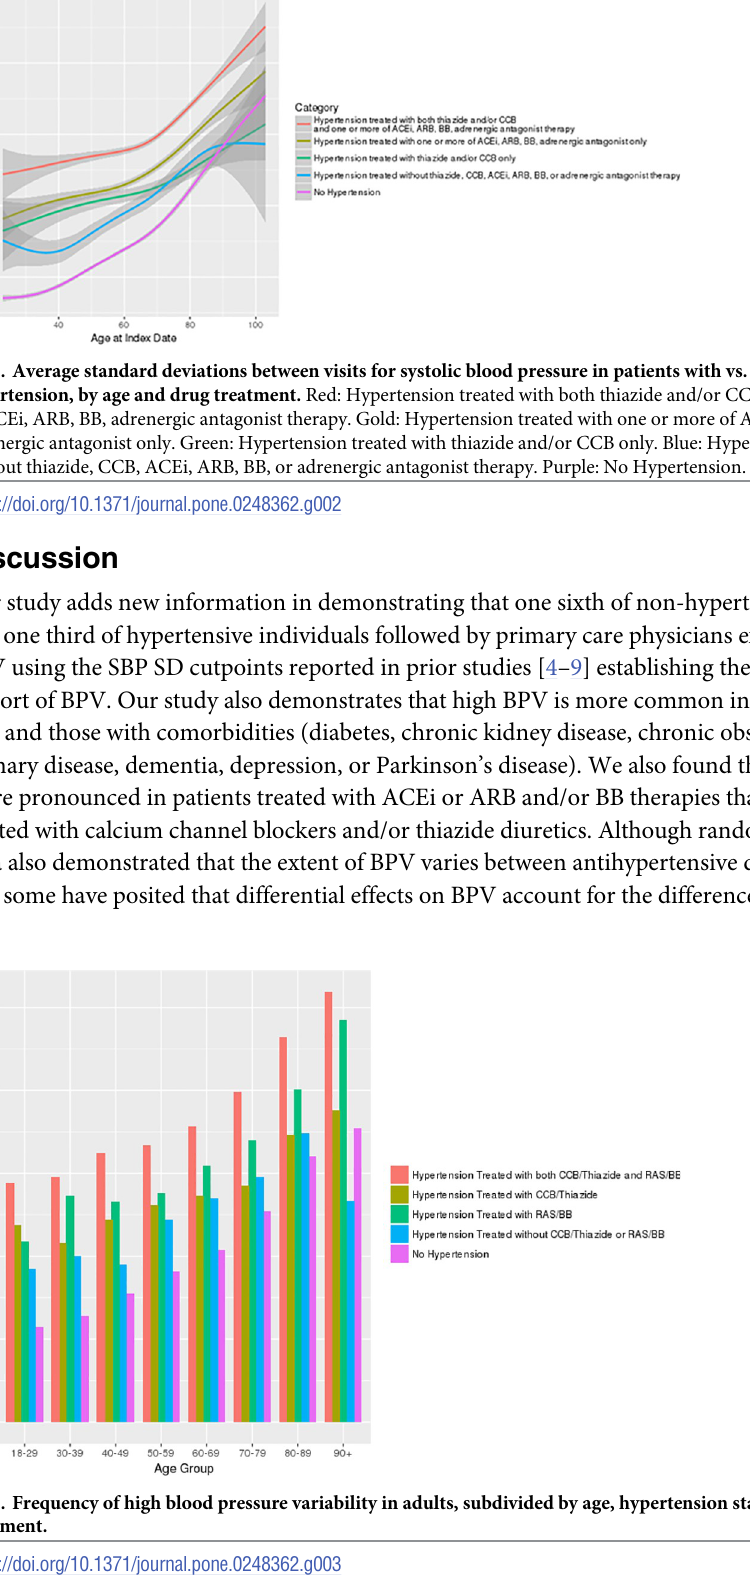
PLOS ONE | https://doi.org/10.1371/journal.pone.0248362 April 2,